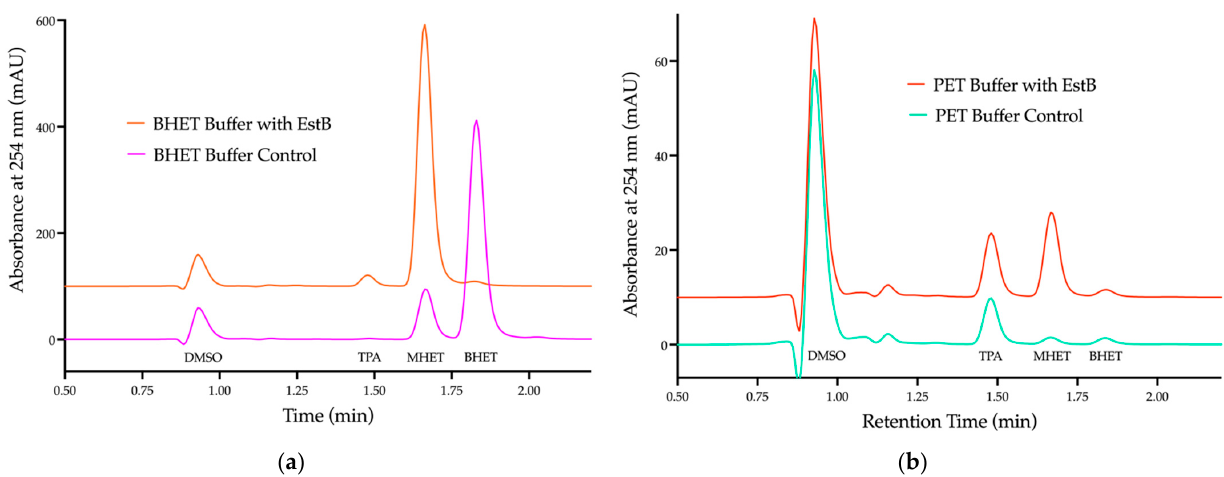
Figure 3. HPLC chromatogram of hydrolysis byproducts from purified EstB incubated on BHET and micro-PET ( a ) Protein EstB incubated on BHET showing significant MHET and TPA accumu- lation ( p < 0.0001) ( b ) Protein EstB incubated on PET showing significant MHET accumulation ( p < 0.0001). All samples were conducted in triplicate and averaged, there was no significant differ- ence between